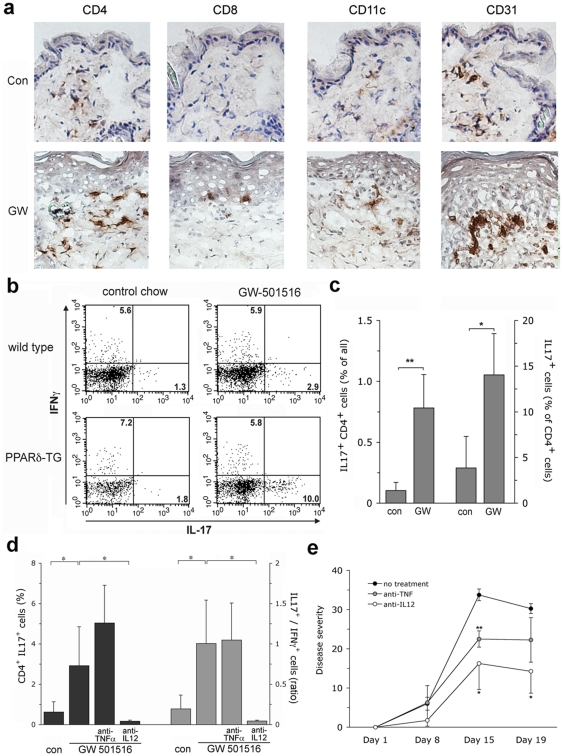
Immune activation in PPARβ/δ-mediated skin disease.(a) Immunohistochemistry for CD4, CD8, CD11c, and CD31 (Pecam 31) of skin from PPARβ/δ transgenic mice maintained in the absence (top) or presence of GW501516. Magnification 200×, (b) flow cytometry analysis showing intracellular FACS-staining for IFNγ and IL17 of skin cells (gated for CD4) from wild type and PPARβ/δ transgenic mice maintained in the presence or absence of GW501516, respectively. Numbers in quadrants indicate frequency of positive cells, (c) frequency of CD4+IL17+ of IL17+ cells (expressed as percent of all CD4+ gated cells) in PPARβ/δ transgenic and C57Bl/6 wild type mice maintained in the presence or absence of GW501516 (n = 4 per group), as determined by flow cytometry. * p<0.01; ** p<0.001, (d) frequency of CD4+IL17+ Th17 cells (left y-axis, black columns) and ratio of IL17+ and IFNγ+ cell frequencies (righ y-axis, grey columns) in the skin of PPARβ/δ mice maintained in the absence or presence of GW501516 with or without i.p. injection of anti-TNFα, or αIL12/23p40 (n = 4, see Methods), (e) disease severity, expressed as mean ± s.d., assessed by the degree of erythema, thickening, scaling, and hair loss (see Methods, representative photographs of mice on day 19 post induction are shown in figure S6) in PPARβ/δ transgenic mice GW501516 – containing chow with or without additional intraperitoneal injection of anti-TNFα or αIL12/23p40 (anti-IL12). * p<0.01, ** p<0.001 (treatment vs. control).